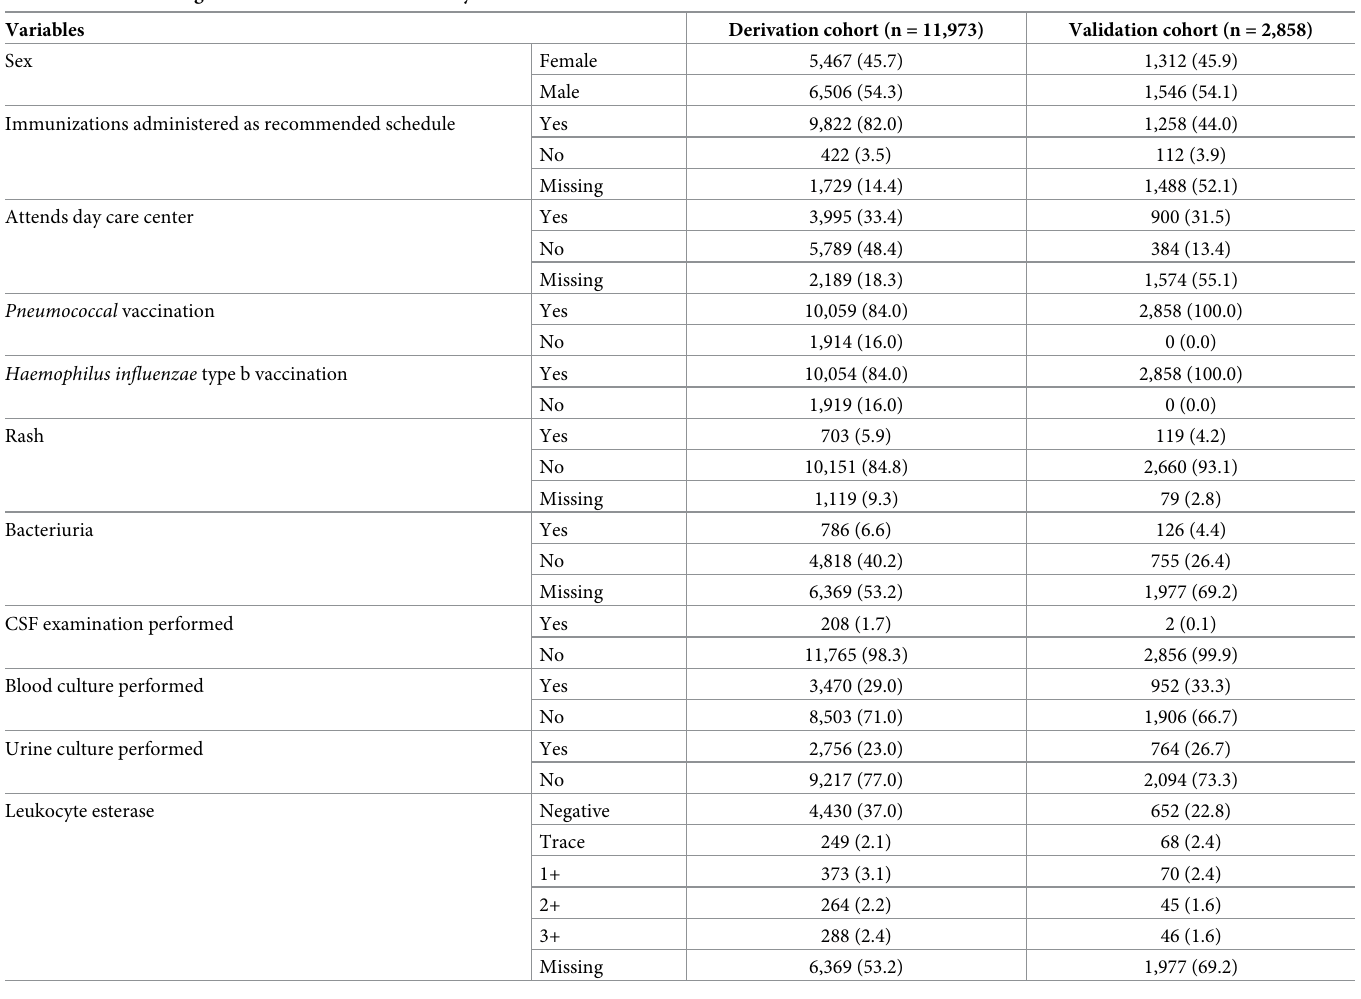
Table 3. Values of categorical variables used in the analysis.